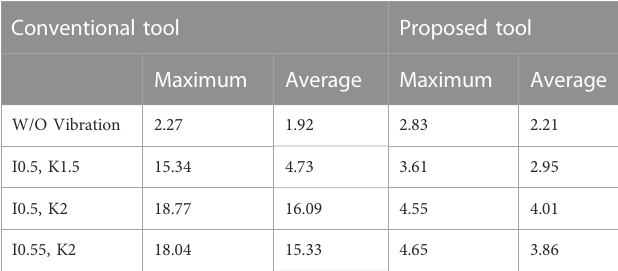
TABLE 3 Summary of roundness